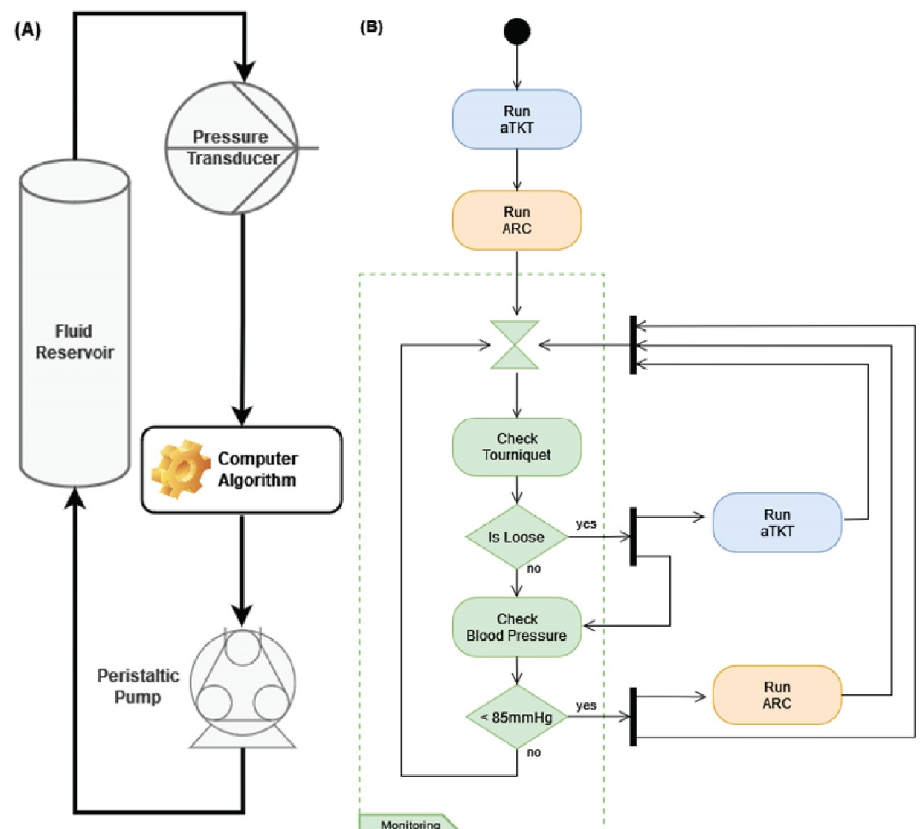
Figure 1. Description of the Closed-Loop Algorithm Architecture. ( A ) ARC for fluid resuscitation. A pressure input is sent to the controller and compared with the desired setpoint; the flow rate is adjusted based on distance from the setpoint. The controller also adapts by comparing performance to trained data sets and modifying the flow rate change amount accordingly. ( B ) SACM combines a previously developed auto-tourniquet with ARC. Decisions and interplay between the two sub-units are controlled by SACM, as shown.